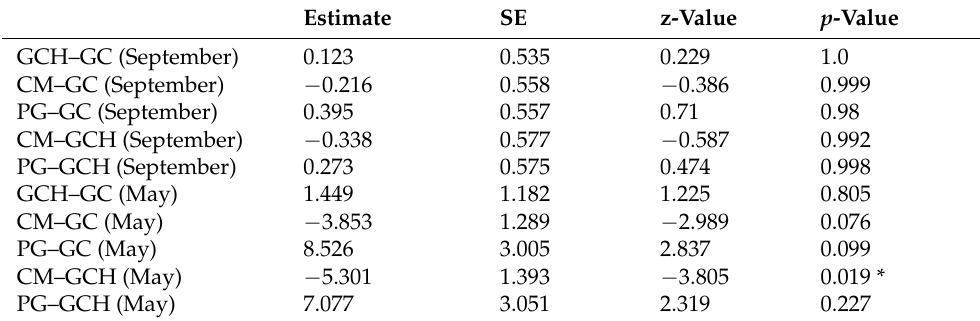
Table A6. Differences in the activity densities of open-habitat carabid beetles, comparing grass–clover (GC) and grass–clover herbs (GCH) with each other, and in comparison to conventional maize (CM) and permanent grasslands (PG) in May/June and September. p -values are indicated as * p < 0.05.